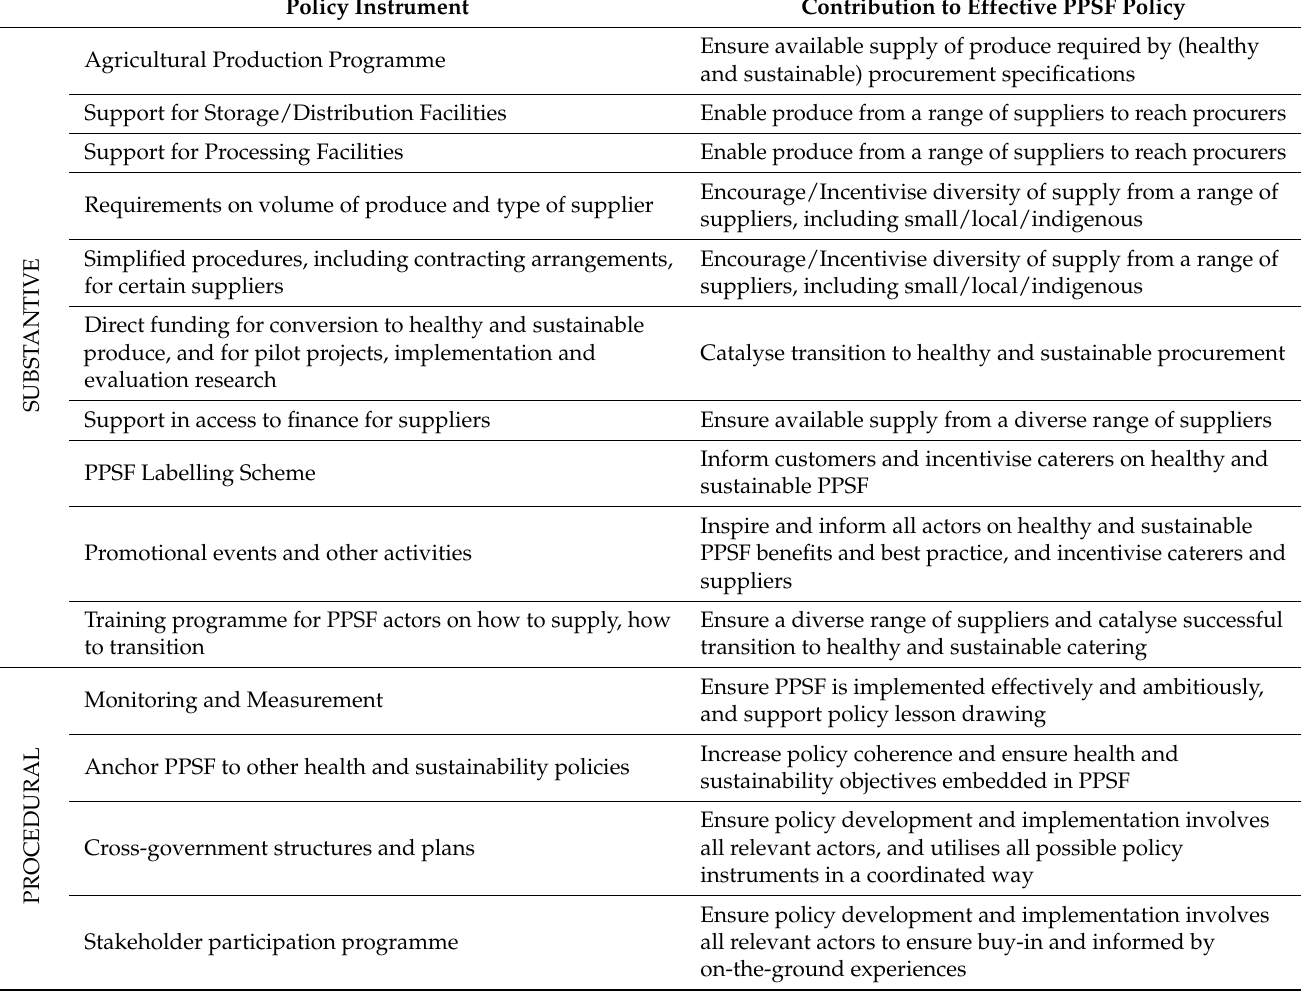
Table 2. Policy package to optimise the transformative potential of food public procurement